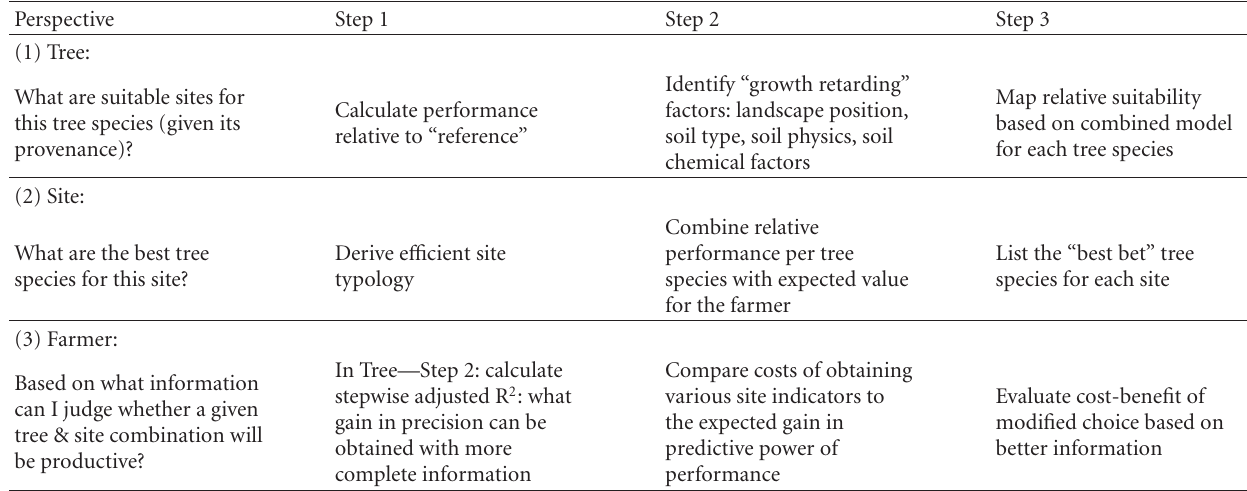
Table 1: Tree-site matching from three di ff erent methodological